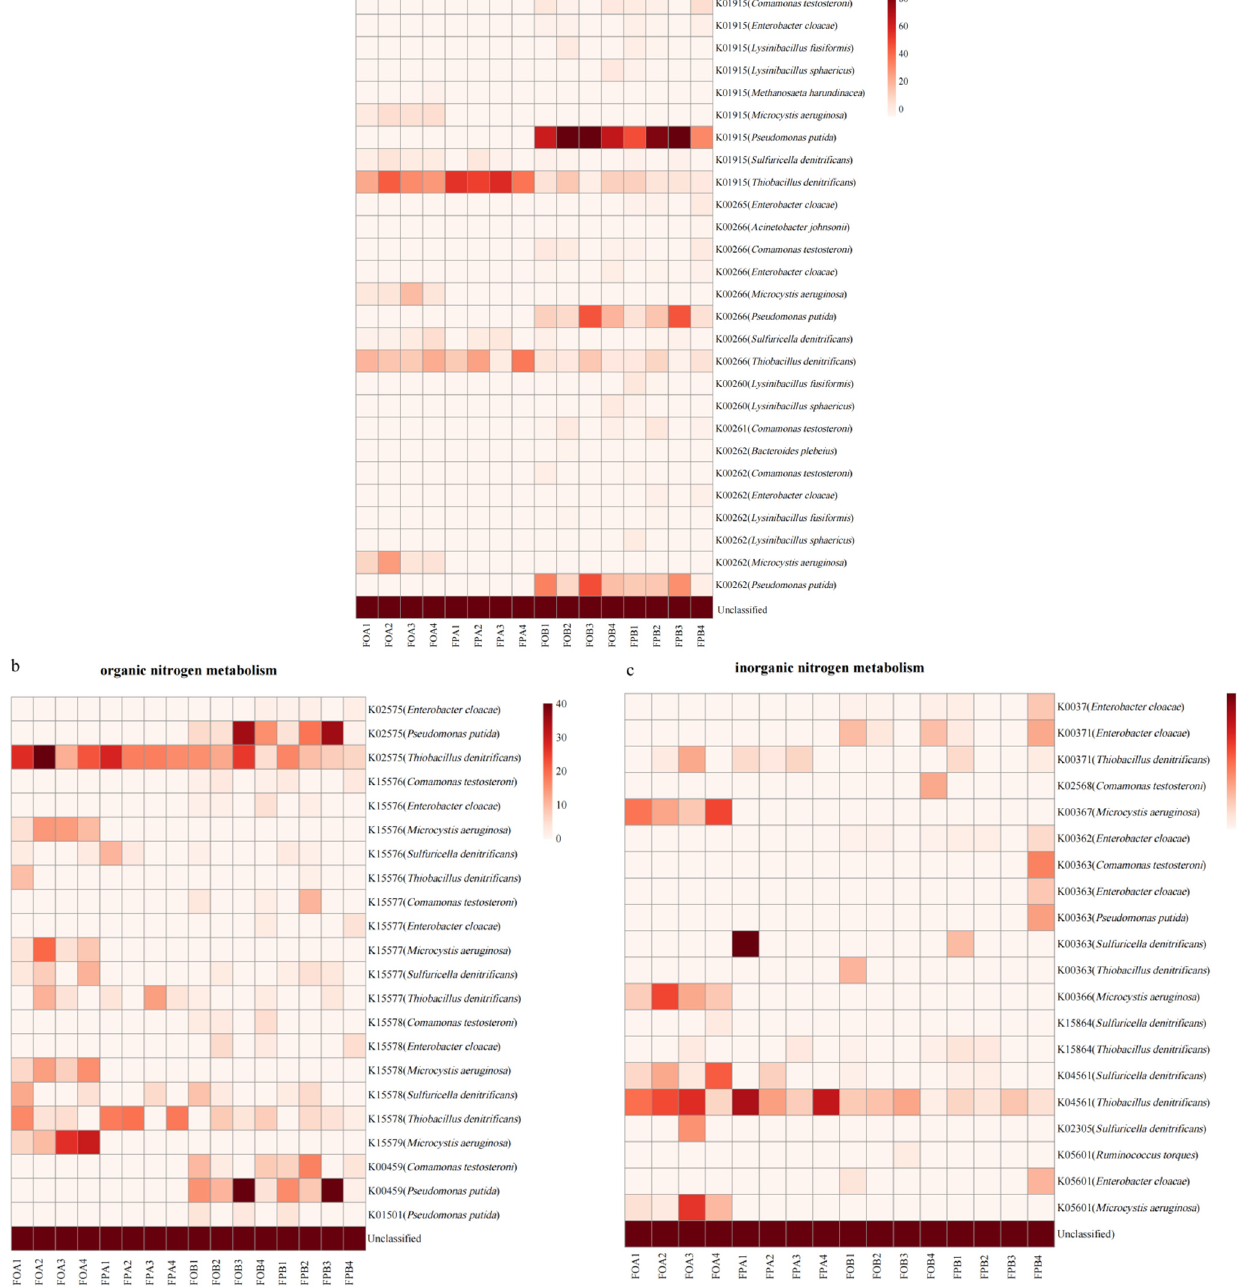
Figure 6. The heat map shows the abundance of genes in different functional pathways of microor- ganisms that were annotated to the nitrogen cycle gene family. The numbers on the ordinate represent the nitrogen cycle metabolic pathways annotated by KEGG, and the contents in brackets are the microorganisms involved in the metabolic pathway.